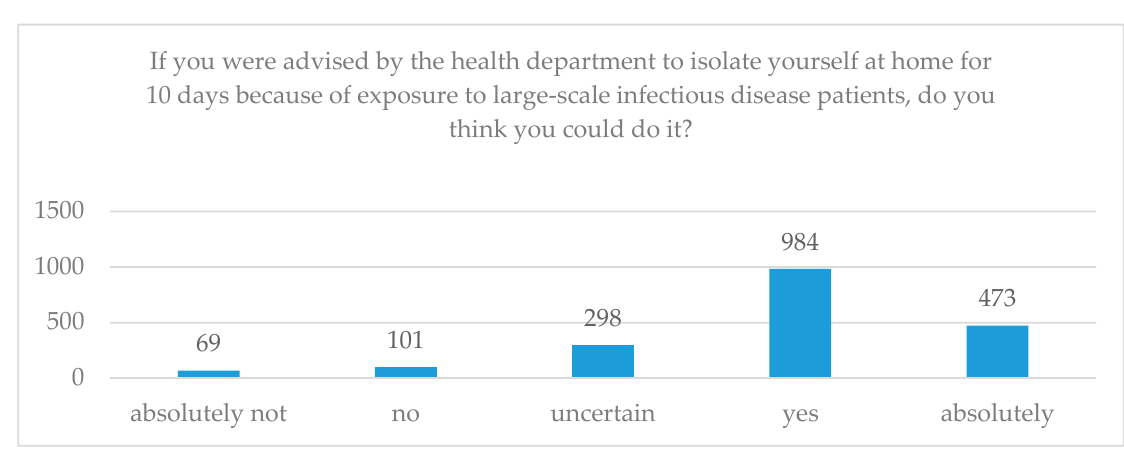
Figure 2. Willingness for SI.